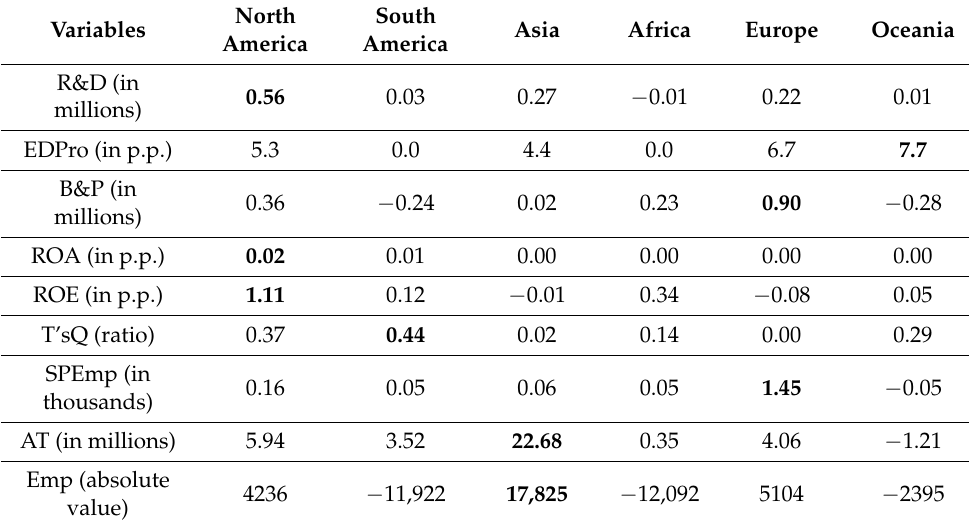
Table 6. Evolution of financial and innovative performance